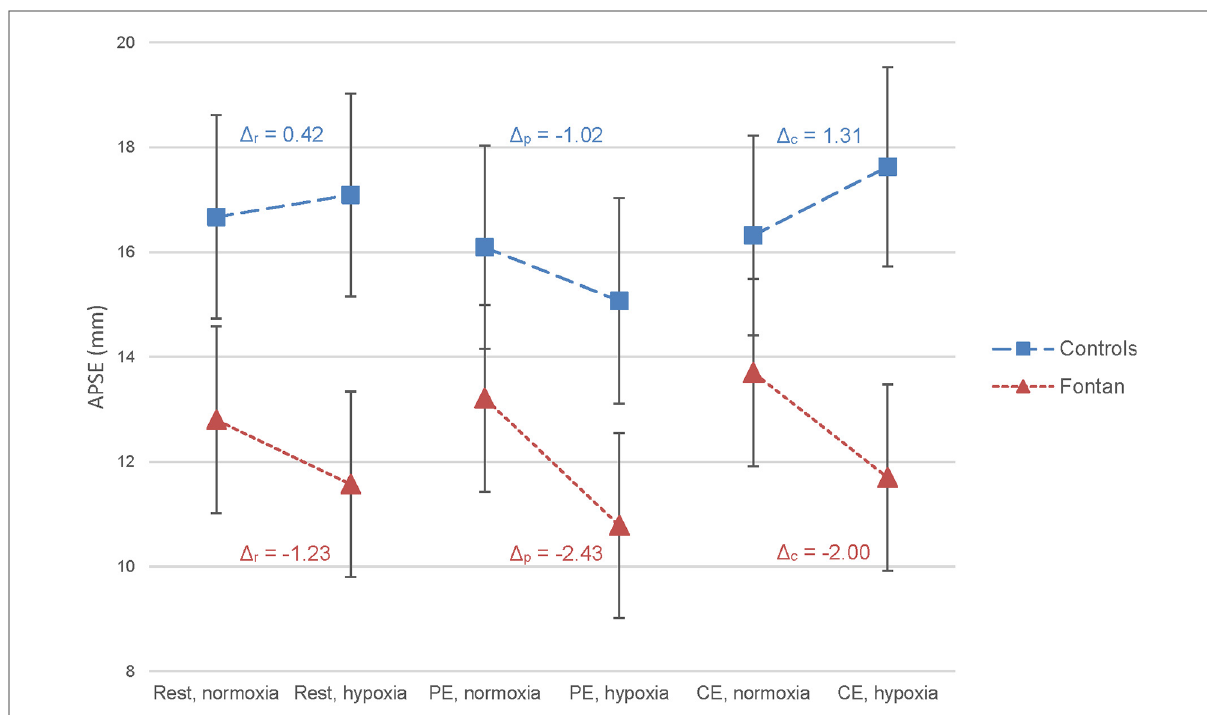
FIGURE 2 Effect of exercise and hypoxia on annular plane systolic excursion (APSE) in Fontan patients and controls analyzed by linear mixed-effects model (LMM). The fi gure displays the mean predicted values with 95% con fi dence interval in the Fontan group (red triangle) and in the control group (blue square) as calculated by LMM. On the x-axis, the studied conditions are presented. Within an exercise level and group, the changes in mean predicted value between normoxia and hypoxia were visually linked by dashed lines and numerically corroborated by the calculation of Δ ( Δ =(mean predicted APSE in hypoxia – mean predicted APSE in normoxia) in mm). Δ r =at rest, Δ p =after peak exercise, Δ c =after continuous exercise. In Fontan patients, hypoxia showed a signi fi cant effect on APSE ( p